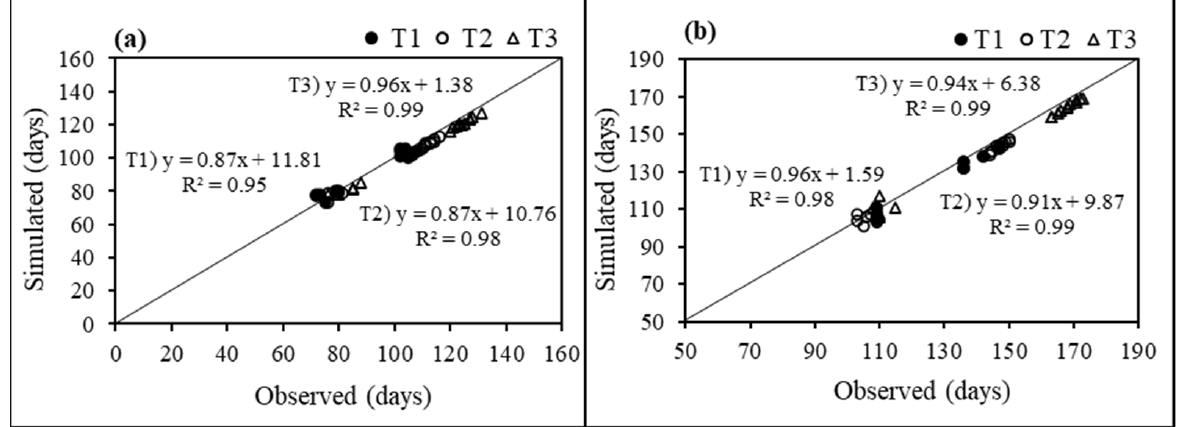
Table 2. RMSEn computed for the grain yield of sixteen upland rice genotypes under T1: control